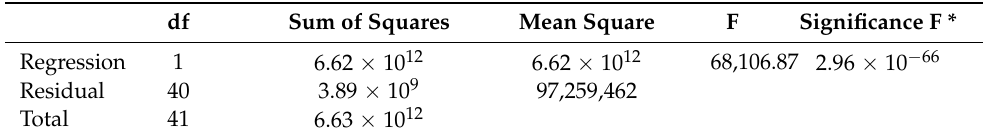
Table 2. Results of analysis of variance (ANOVA) for linearity. df Sum of Squares Mean Square F Significance F